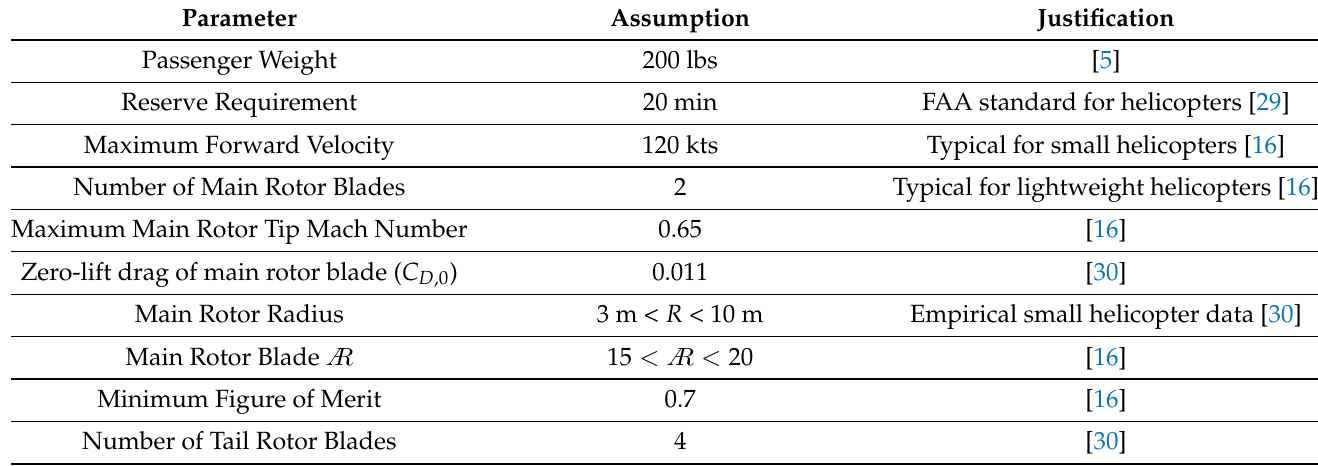
Table A1. List of assumptions and constraints used in the design